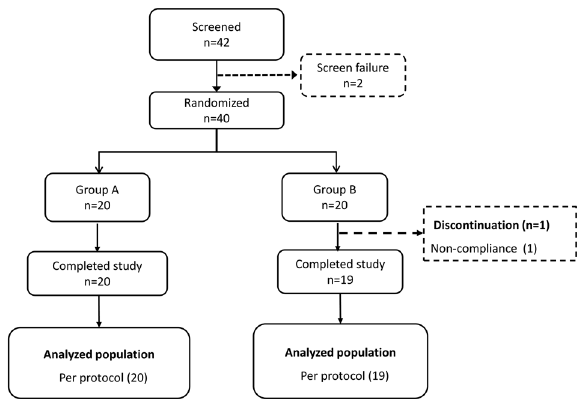
Fig. 1 CONSORT diagram. Group A, received green jackfruit fl our meal. Group B, received placebo meal.